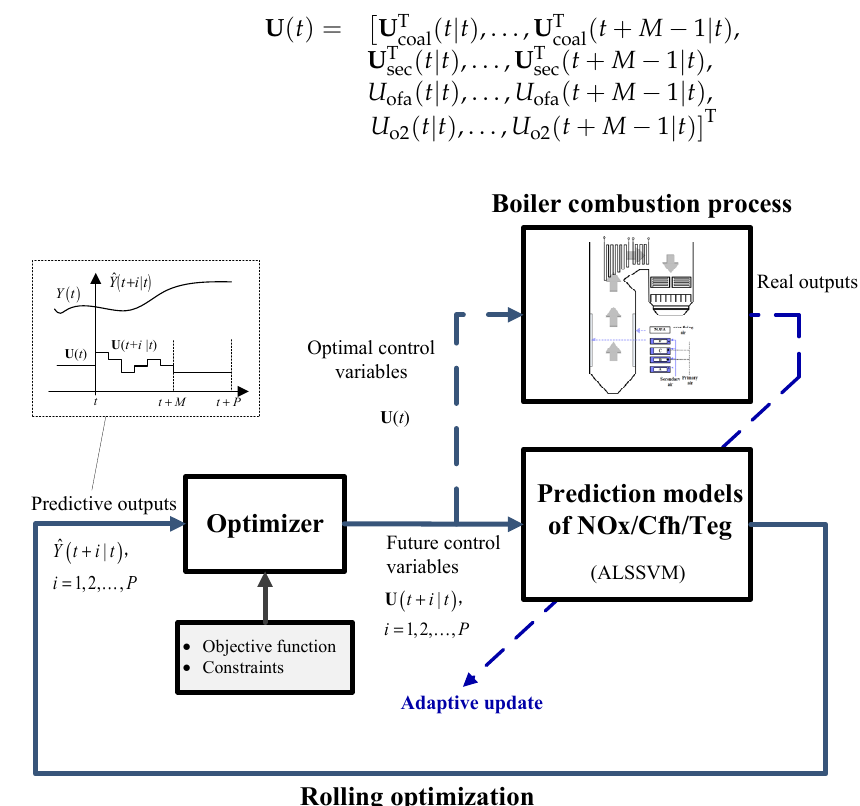
Figure 4. Structure of the closed-loop combustion optimization system.